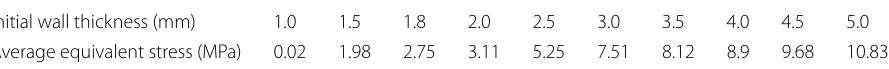
Table 3 Average equivalent stress of rubber cylinder with different wall thickness Initial wall thickness